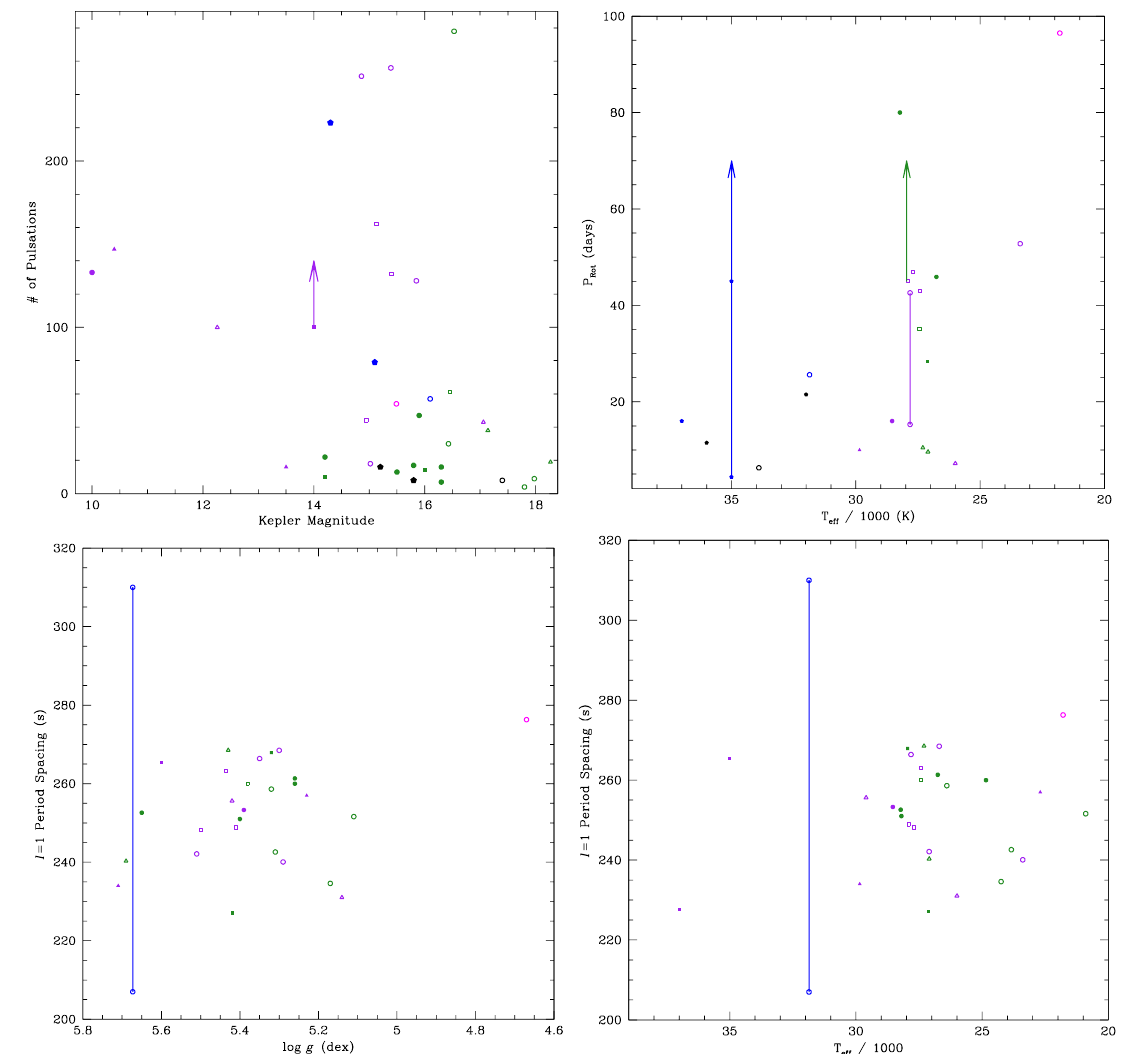
Figure 3. Comparisons of Kepler-observed pulsators. Point types are the same as in Fig.1. Top left: Number of pulsation frequencies ob- served (provided in Table1 compared with magnitude. Arrow indicates a lower limit, as that star is still in analysis. Top right: Rotation pe- riod with T eff . Arows indicate lower limits and lines indicate radially differential rotators, with the envelope having the shorter period. Bot- tom panels show g mode ℓ = 1 asymptotic period spacings with log g and T eff . Lines connect the two possible period spacings for